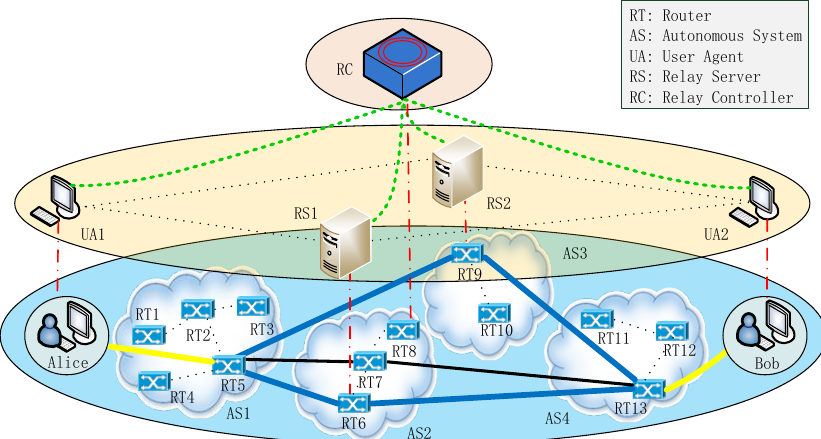
Figure 2. The topology of a software defined overlay network.